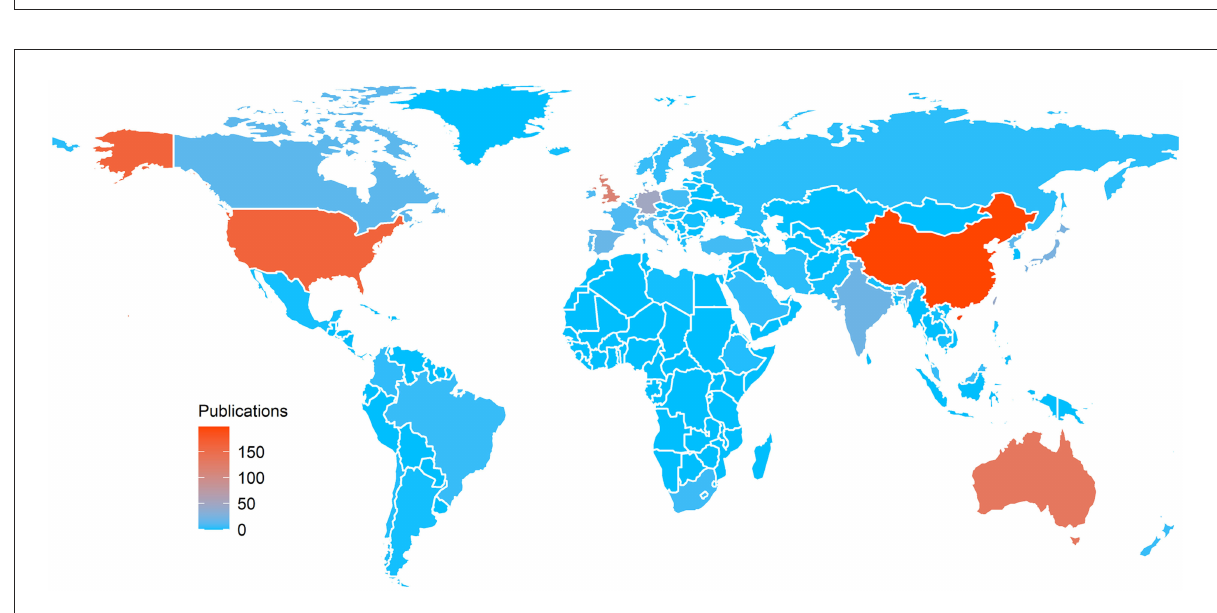
FIGURE2 Hot map based on publications according to